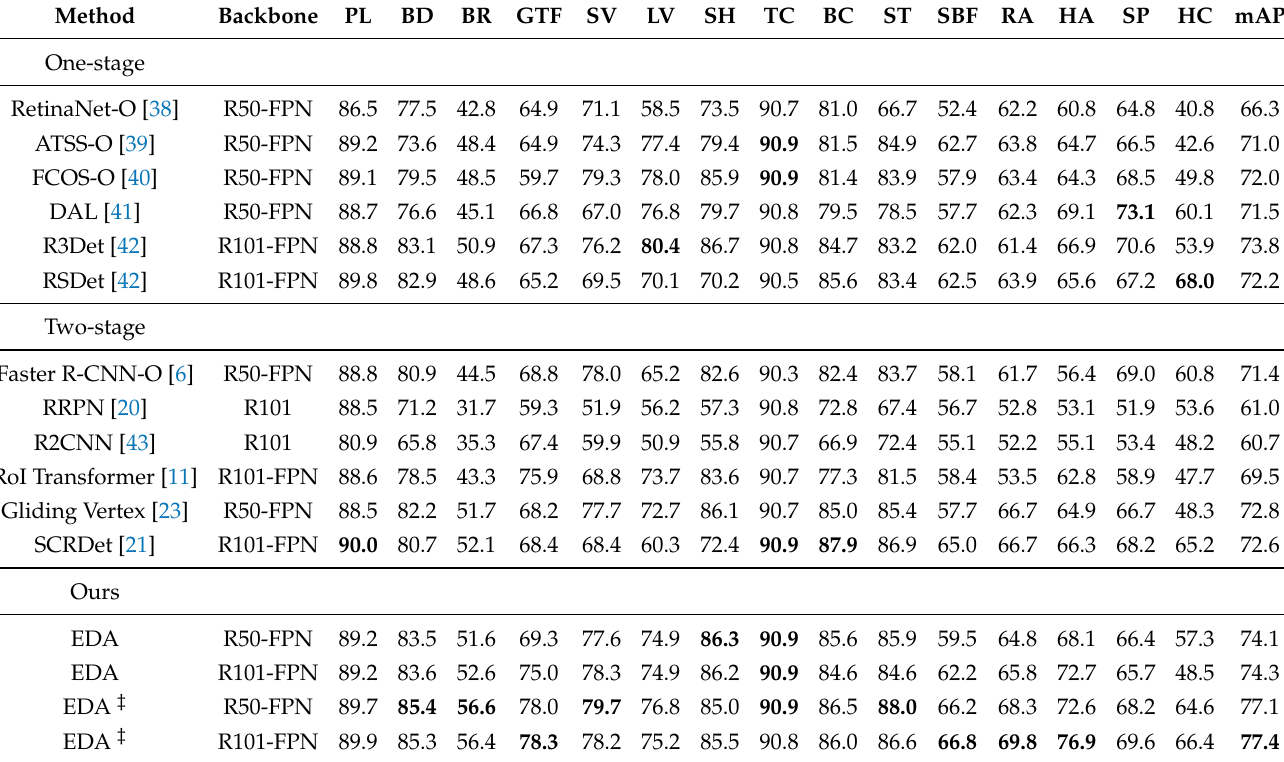
Table 3. Quantitative comparisons on DOTA. ‡ denotes multi-scale training and